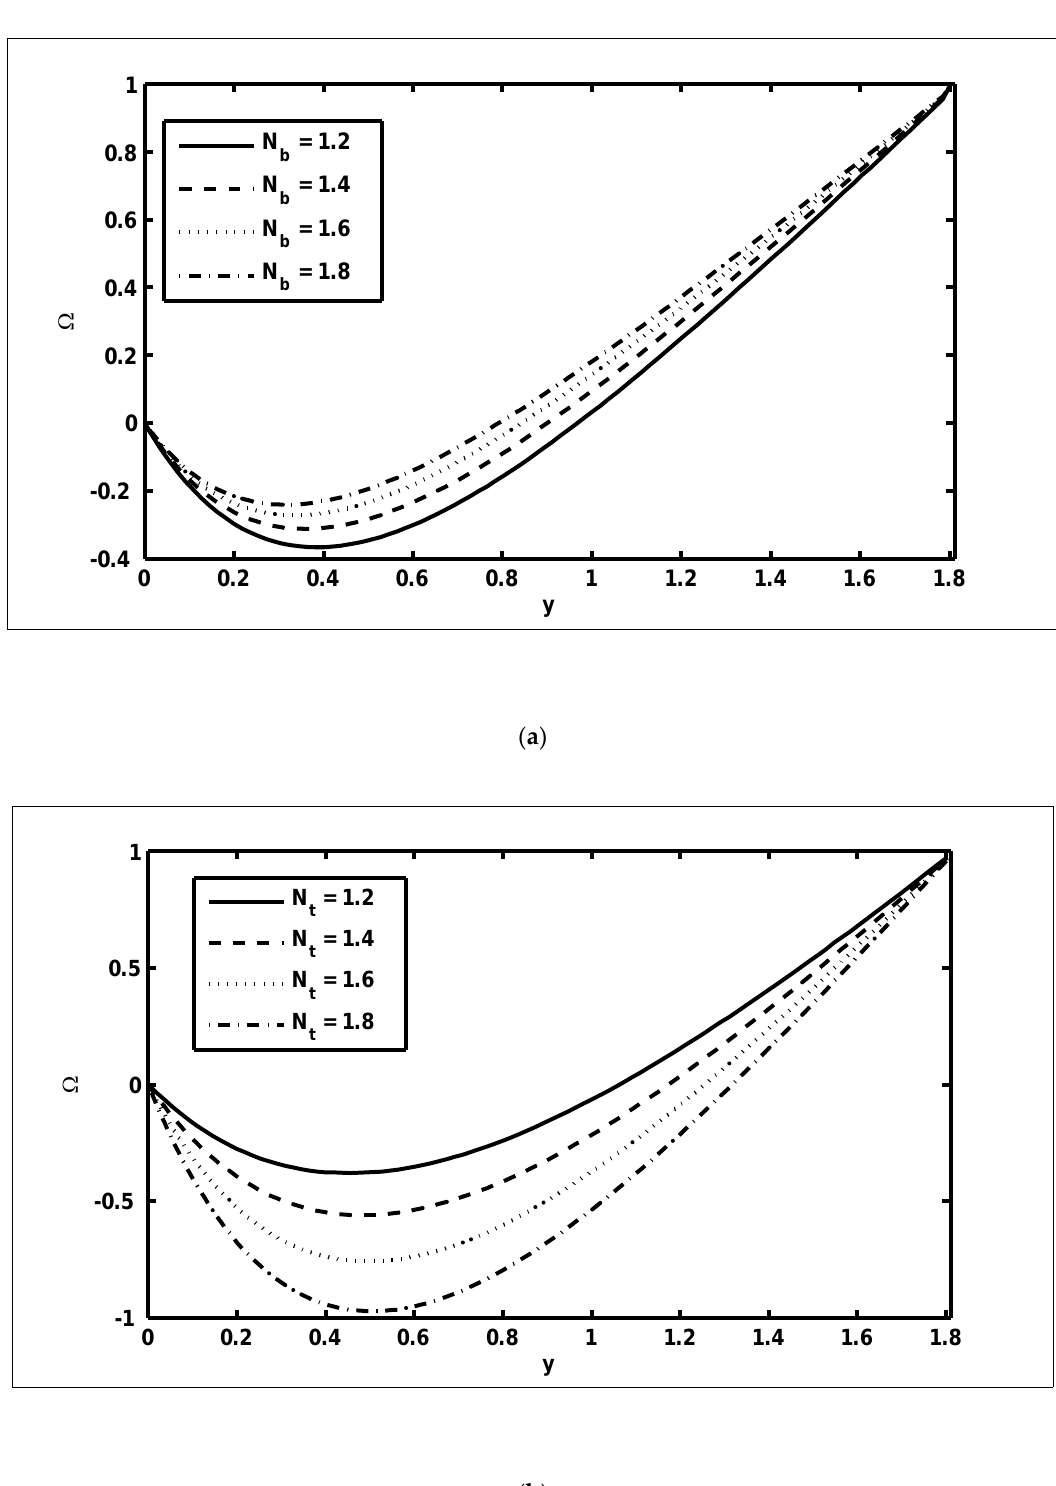
Figure 7. The nanoparticle fraction profiles ( 𝛺 ): ( a ) 𝑁 𝐶𝑇 = 0.9, 𝑁 𝑇𝐶 = 0.7, 𝑁 𝑡 = 0.9, 𝛽 = 0.4, 𝑚 = 0.2, 𝑥 = 0.2 ; ( b ) 𝑁 𝐶𝑇 = 0.9, 𝑁 𝑇𝐶 = 0.7, 𝑁 𝑏 = 0.9, 𝛽 = 0.4, 𝑚 = 0.2, 𝑥 = 0.2.